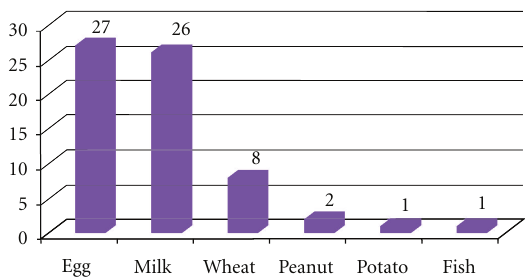
Figure 3: Sensitization to food allergens (absolute numbers of sen- sitized infants) in the group of symptomatic infants at 12 months of age ( n = 43).